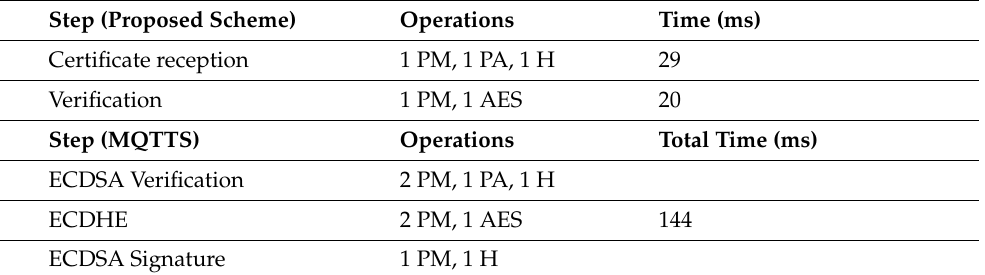
Table 6. Comparison of computational overhead of the operations on a Raspberry PI 3B in our proposed scheme versus